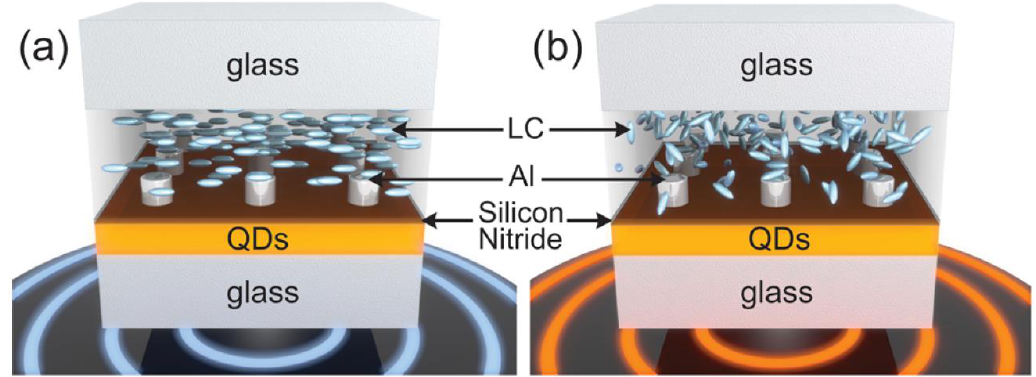
Figure 10. Schematic diagram of the temperature-dependent hybrid system using thermotropic LCs. ( a ) LC molecules are ordered at room temperature. ( b ) LC molecules are disordered at higher temperatures (>58 °C). Reproduced with permission from [111]. Copyright American Chemical Society, 2014.